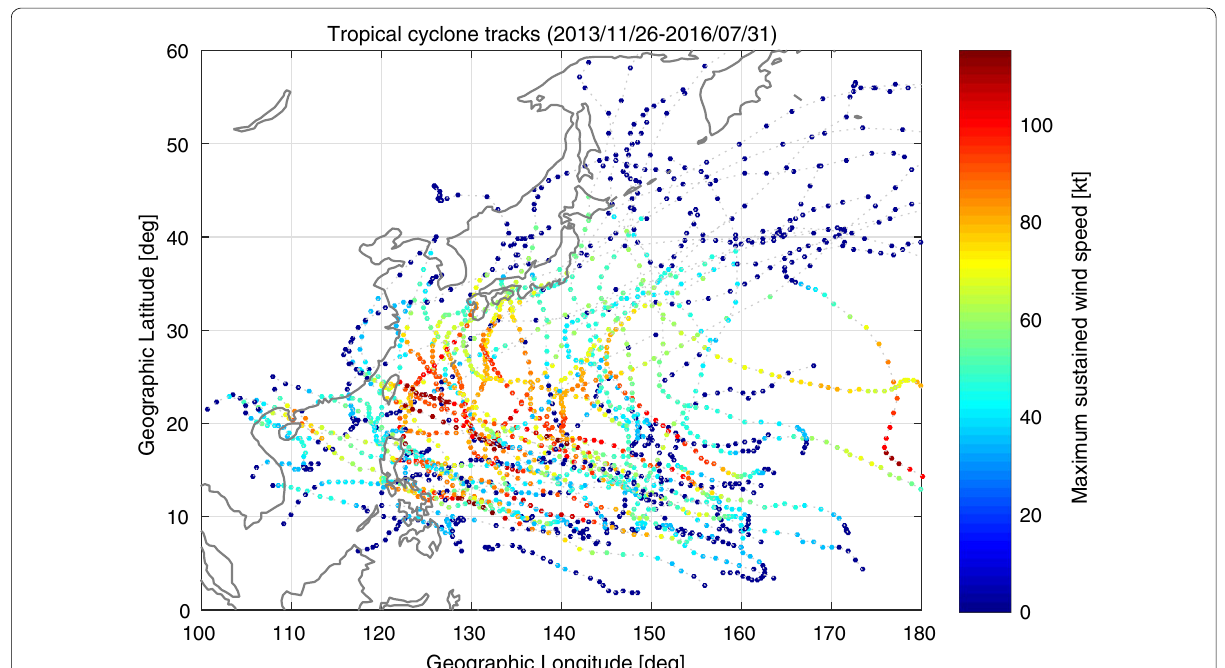
Fig. 14 Tracks of typhoons as listed in Table 1. The color shows the maximum sustained wind